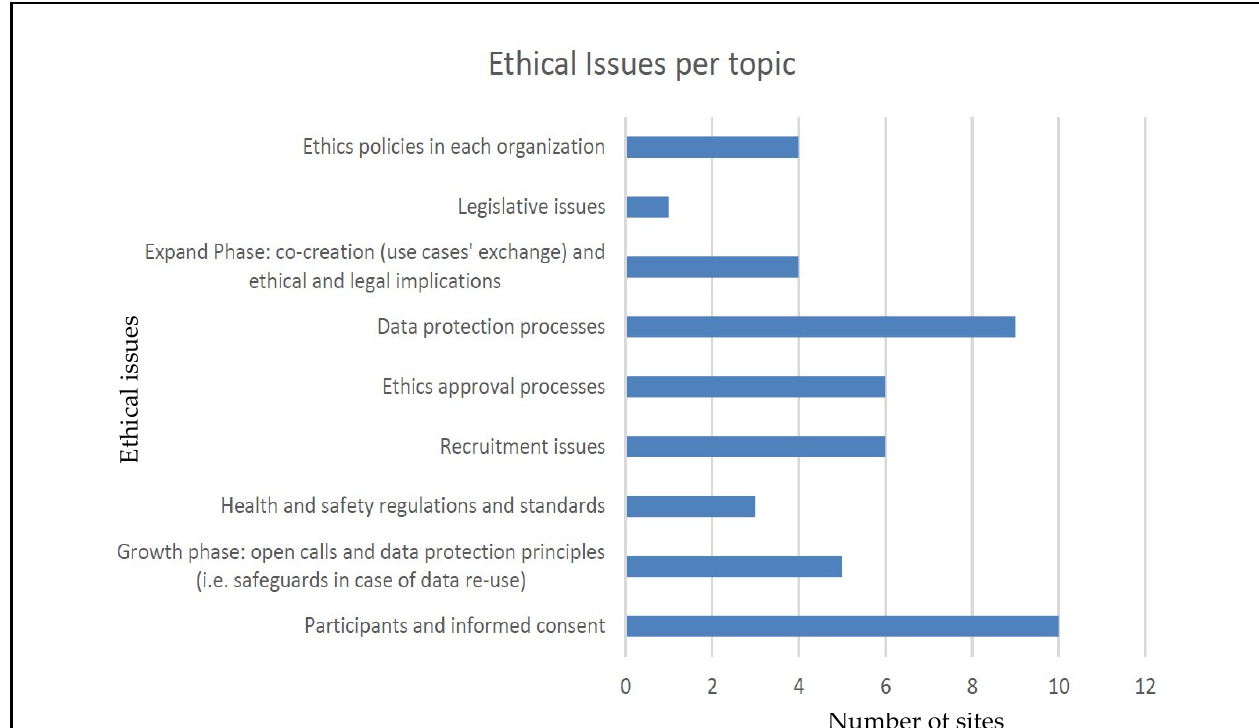
Figure 3. Number of declared issues per topic.